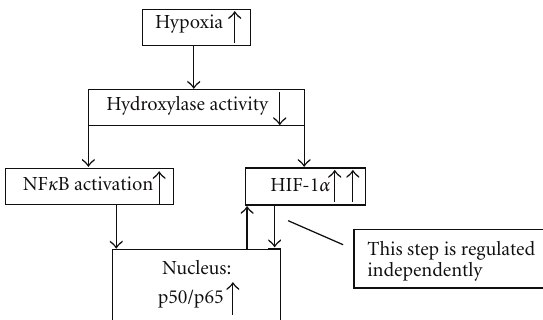
Figure 8: Proposed mechanism of hypoxia on HIF-1 and NF κ B activation in PBMC. Hypoxia causes a reduction of hydroxylase activity leading on the one hand to the activation of NF κ B and a consecutive transport of the p50/p65 complex into the nucleus. Binding of p50/p65 to the corresponding promotor side of the HIF- 1 α gene results in an increase of HIF-1 α protein in the cytosol. On the other hand, reduced hydroxylase activity prevents HIF- 1 α degradation by the proteasome increasing cytosolic HIF-1 α concentration. Under hypoxic conditions equivalent to a height of 5500m, an increase of cytosolic HIF-1 α did not raise the HIF-1 α concentration in the nucleus indicating that not only the HIF-1 concentration in the cytosol, but also the transport into the nucleus is